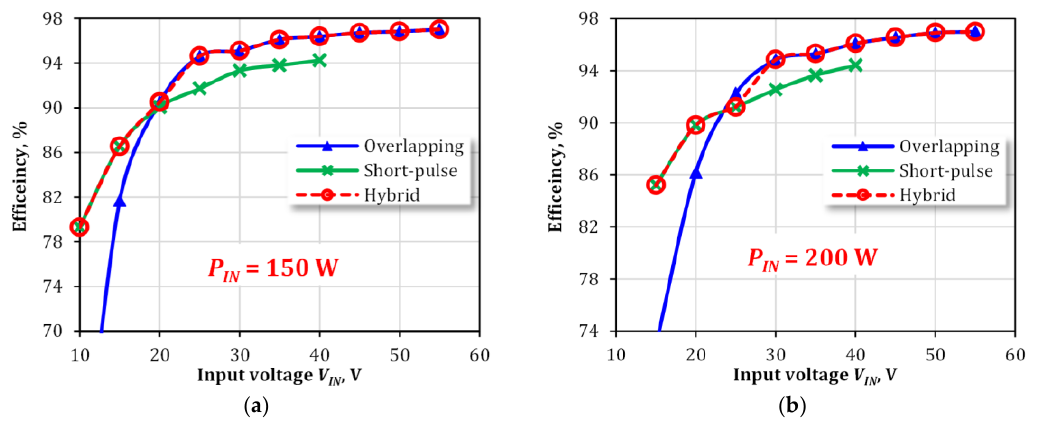
Figure 17. Experimental efficiency dependence on the input voltage for different PWM schemes evaluated at fixed input power values: ( a ) P IN = 150 W; ( b ) P IN = 200 W.